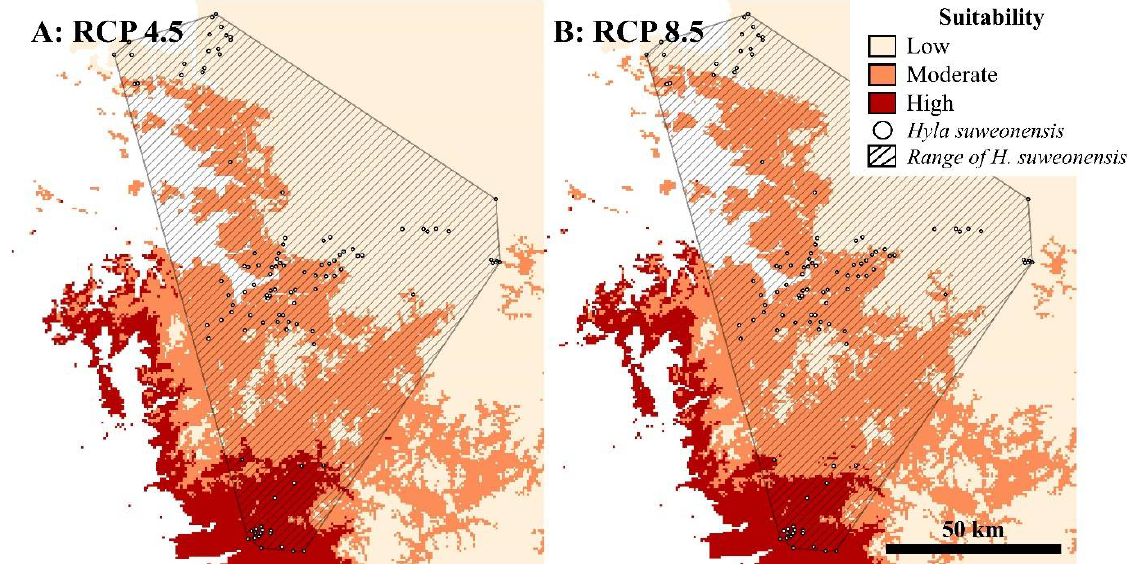
Figure 3. Overlapping with the distribution of H. suweonensis with the distribution of Lithobates catesbeianus in each scenario. ( A ) RCP 4.5, ( B ) RCP 8.5.